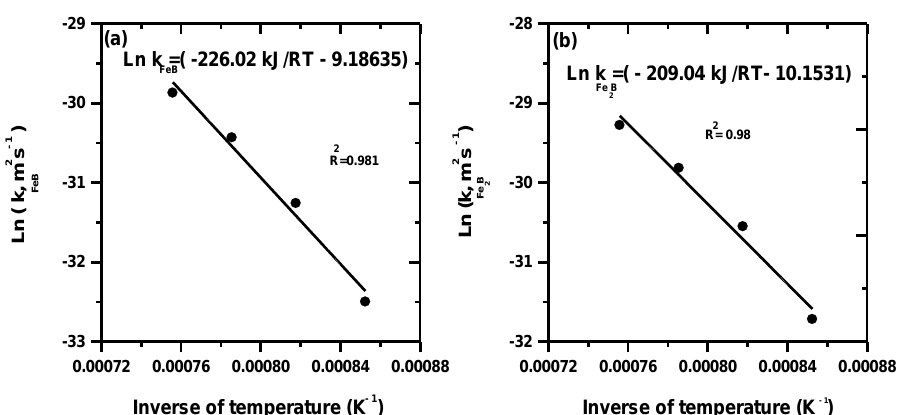
k and k determined from the determined from the FeB BFe 2 B 2